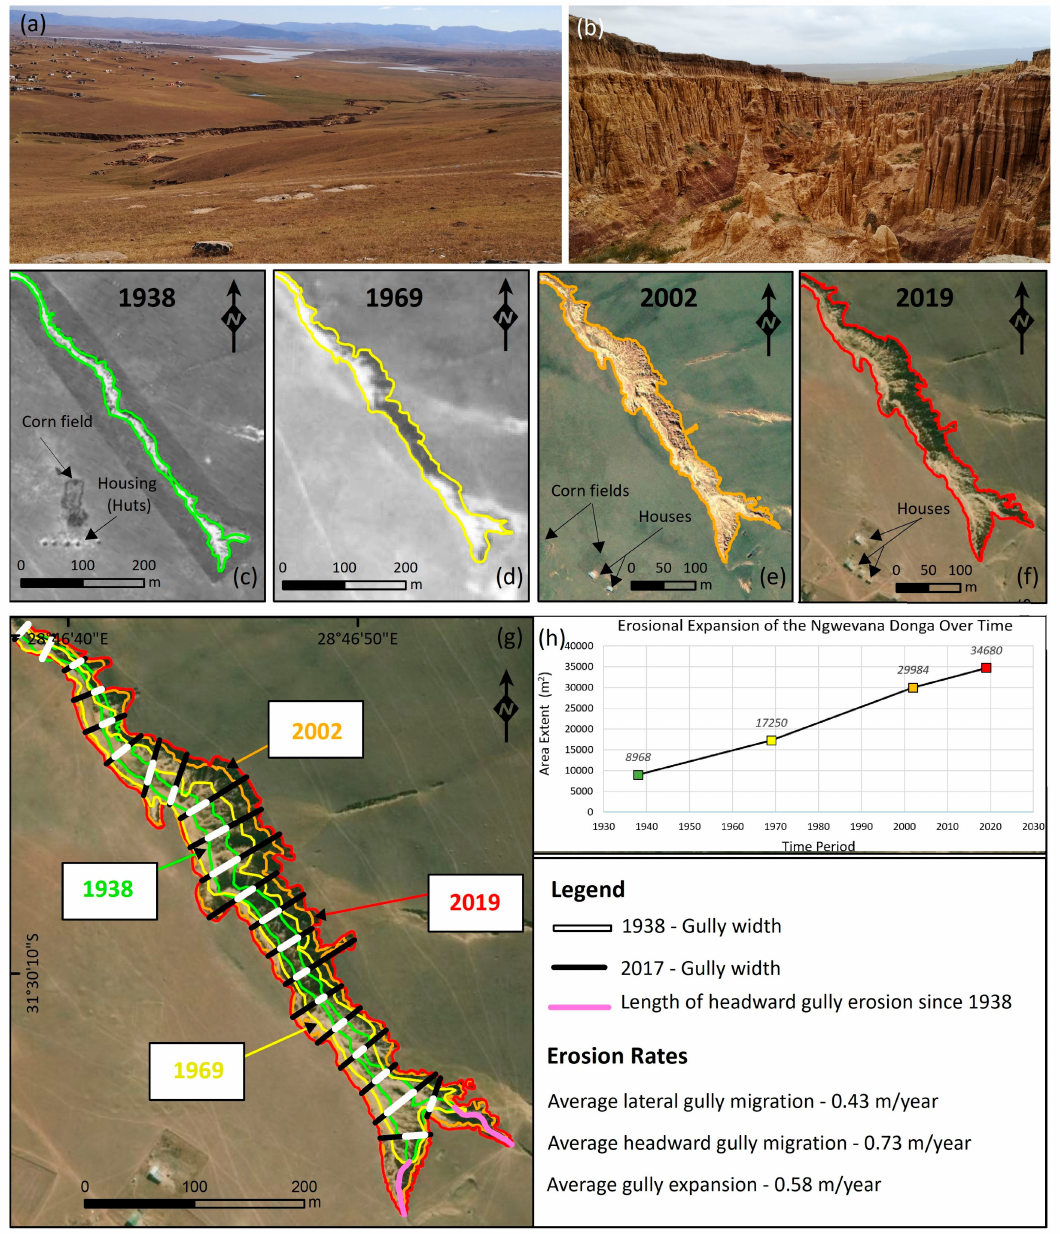
Figure 10. Spatial mapping of erosion rates at the Ngwevana Gully, near Mthatha (Figures 1 and 4 for location): ( a ) Landscape view looking northwest; ( b ) outcropping Masotcheni Formation and Beaufort Group rocks into which the gully is incised; ( c – f ) individual aerial views outlining the perimeter of the gully at di ff erent times; ( g ) superimposed gully perimeter outlines showing consistent lateral and head ward gully expansion; and ( h ) plotted results show an overall increase in gully area from 8968 m 2 to 34,680 m 2 over the last 81